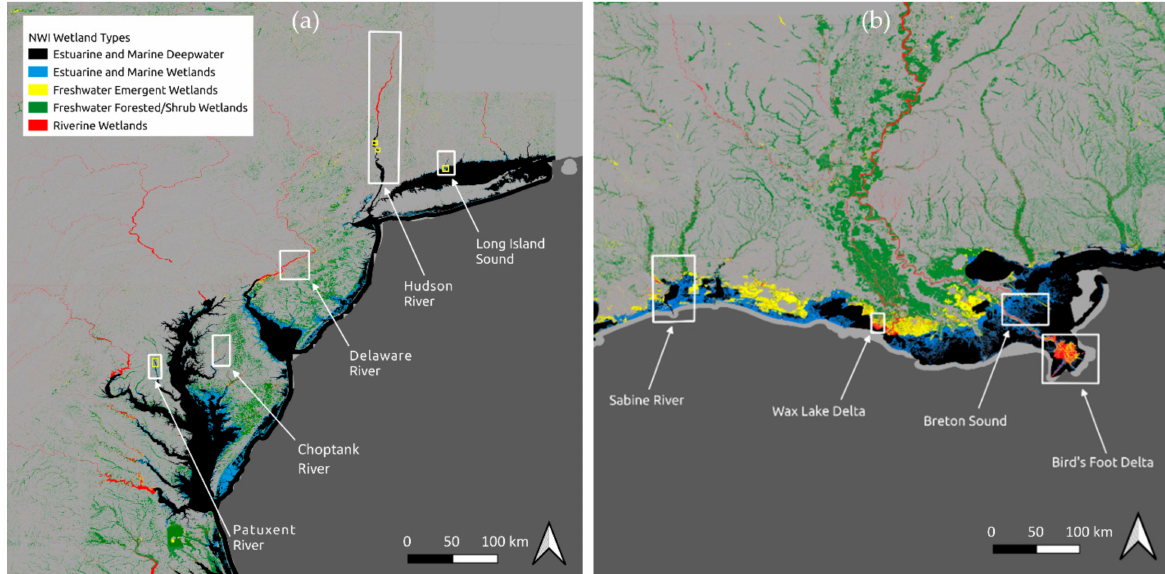
Figure 1. General study sites in the Mid-Atlantic ( a ) and Gulf Coast ( b ) shown in white rectangles. Intensive study sites for the Mid-Atlantic region are also shown as yellow rectangles within general study sites. These intensive study sites are depicted in more detail in Figure 2 as well. From north to south, intensive study sites are as follows: Beacon Bridge wetlands and Constitution Marsh in the Hudson River, Wheeler Marsh in the Long Island Sound, and Jug Bay wetlands in the Patuxent